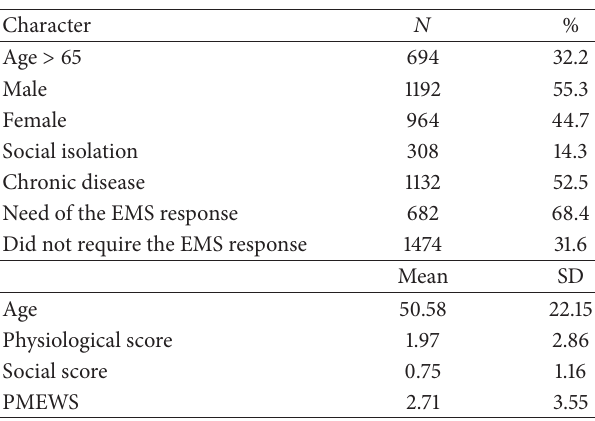
Table 2: Patient’s characteristics.